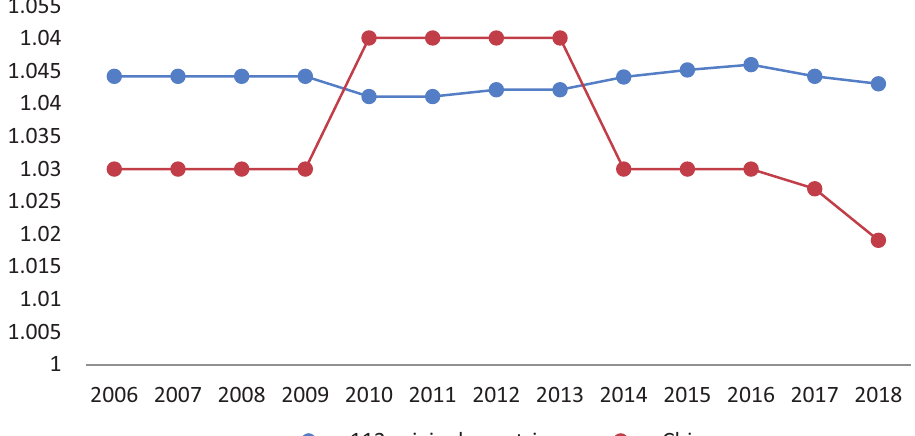
Figure 7. Time series comparison of gender gap index in healthy life expectancy. Source: WEF (2006, 2008–2018).